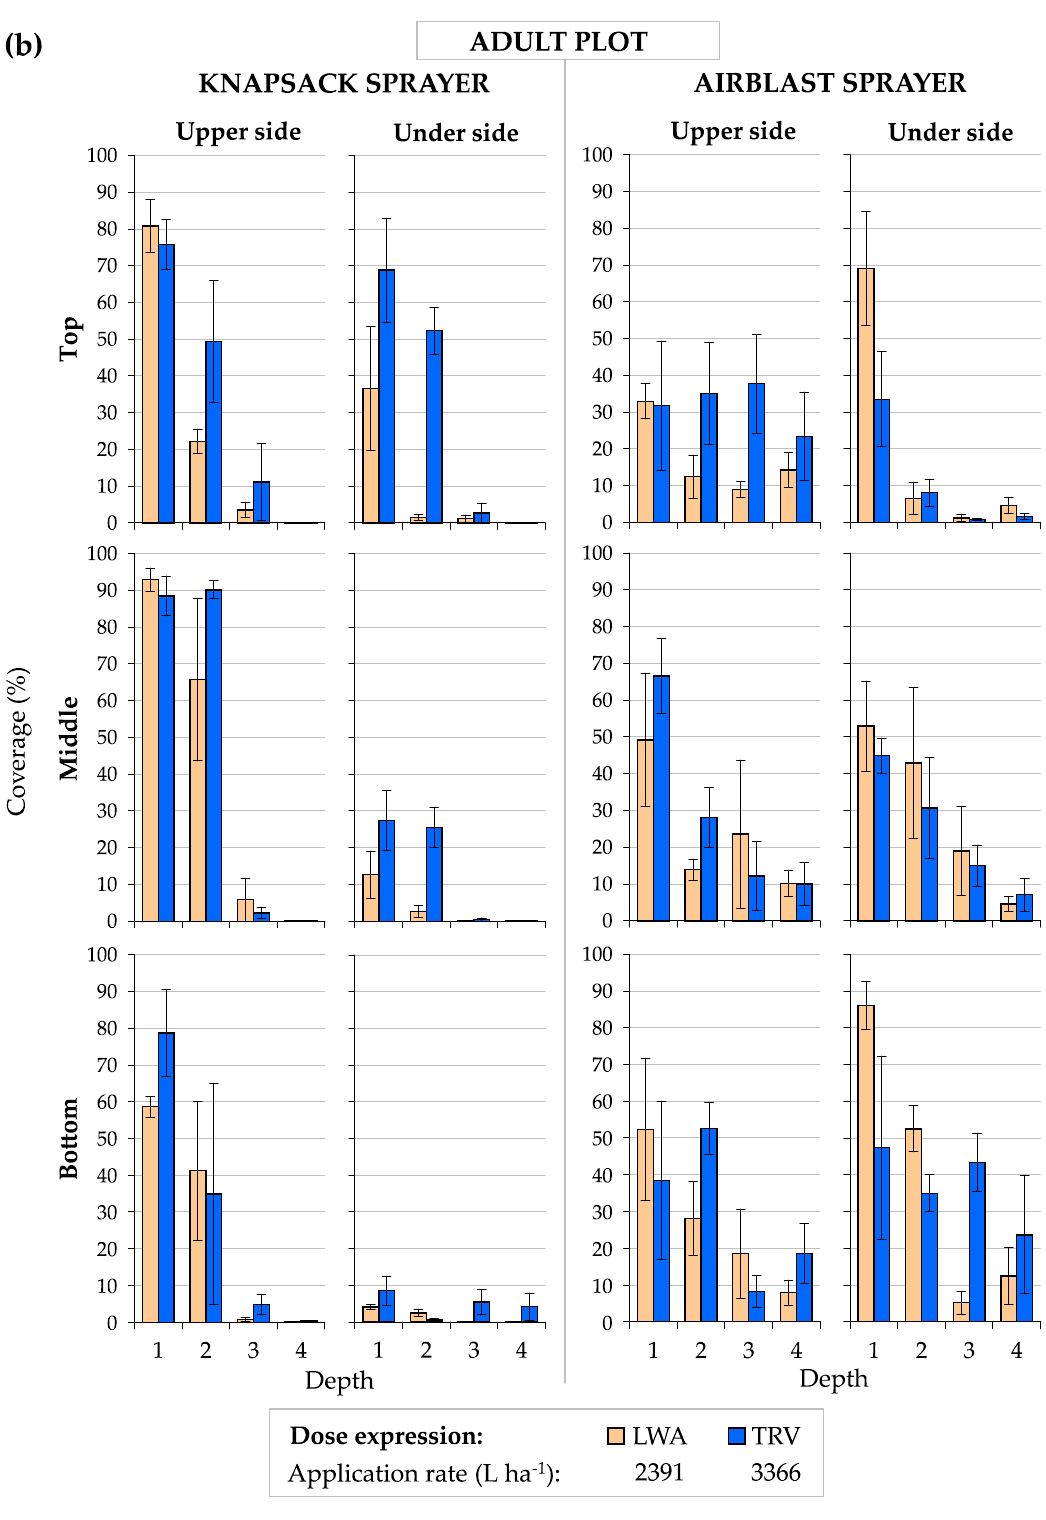
Figure A1. Spray coverage (mean (s.e.), %) in the different areas of the canopy (height, depth, and leaf side) depending on the application sprayer and the dose expression in the ( a ) young and ( b ) adult plots.